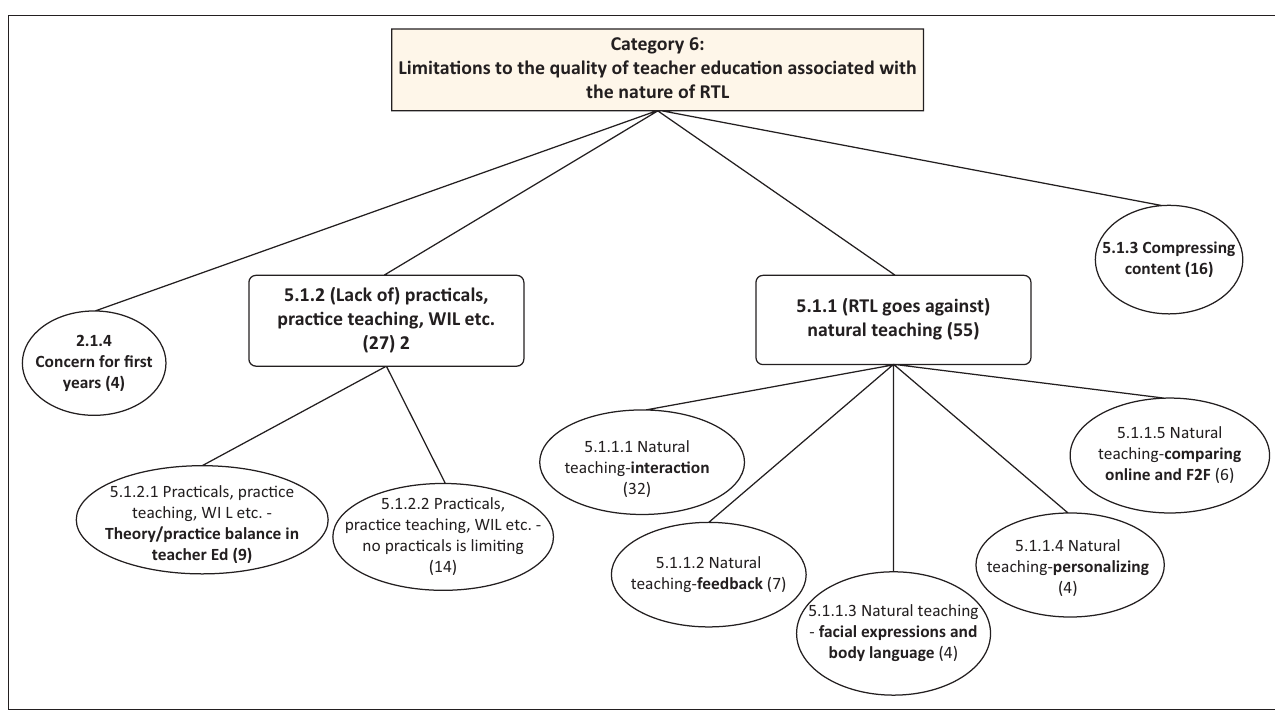
FIGURE 3: Example of the composition of a category and its